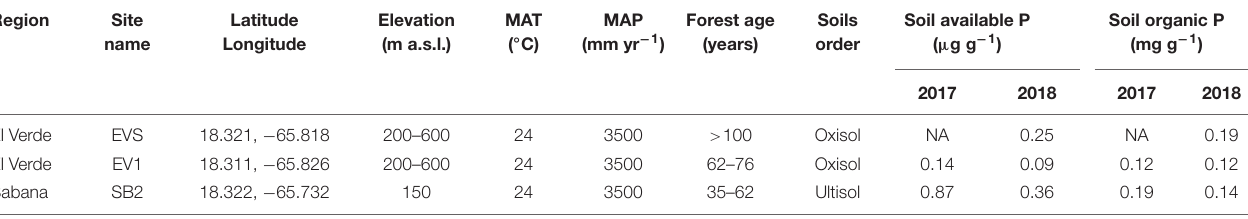
TABLE 1 | Environmental conditions of the studied sites at the Luquillo Experimental Forest (LEF). Region Site